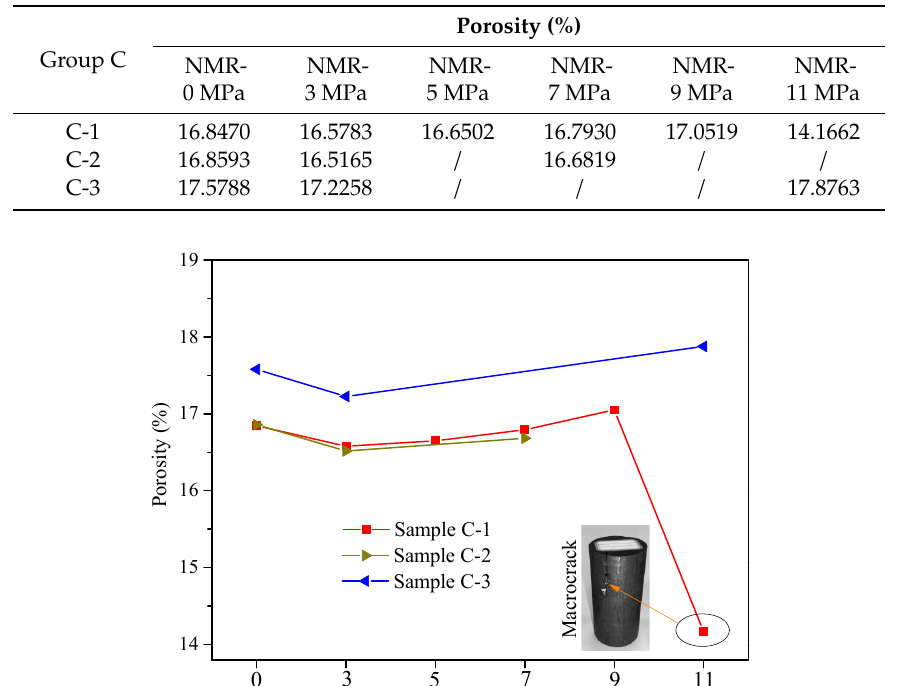
Table 1. Porosity of the coal samples in Group C under different loads.